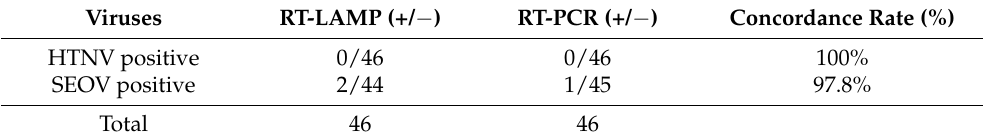
Table 3. Comparison of the multiplex RT-LAMP assay with RT-qPCR assay using HFRS-suspected patients.